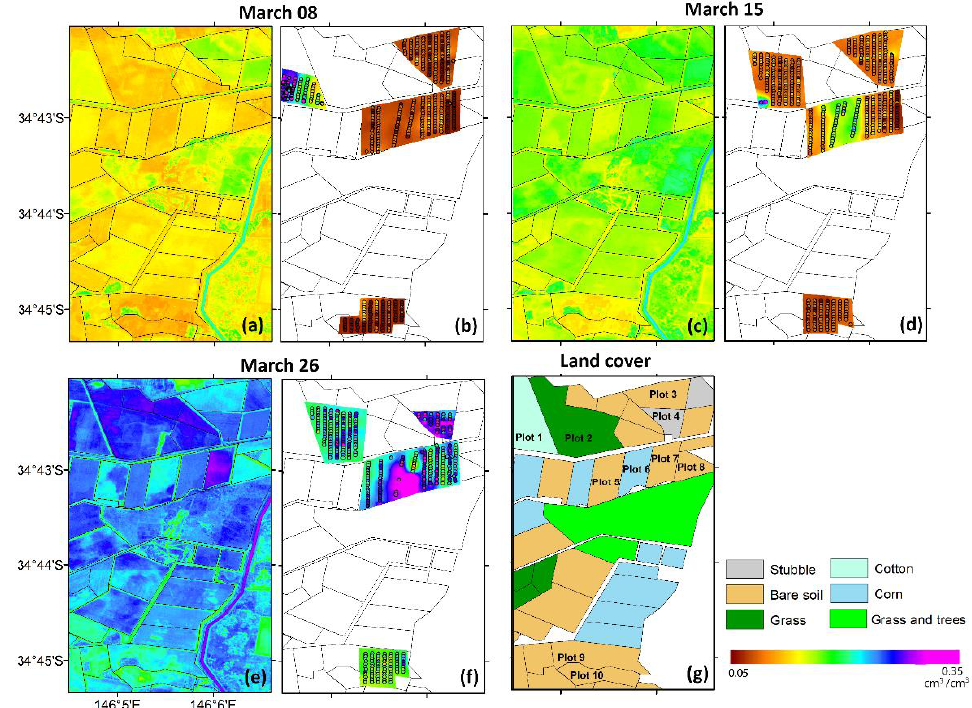
Figure 5. The downscaled (3-m) SSM patterns derived using the combined ML and CDF-matching approach ( a , c , e ) and interpolated SSM maps generated from intensive HDAS ground measurement sites (dots) ( b , d , f ) over the focused study area for 8 March 2021 ( a , b ), 15 March 2021 ( c , d ), and 26 March 2021 ( e , f ); field plots with HDAS measurements are labeled on the land cover map for the same area ( g ).